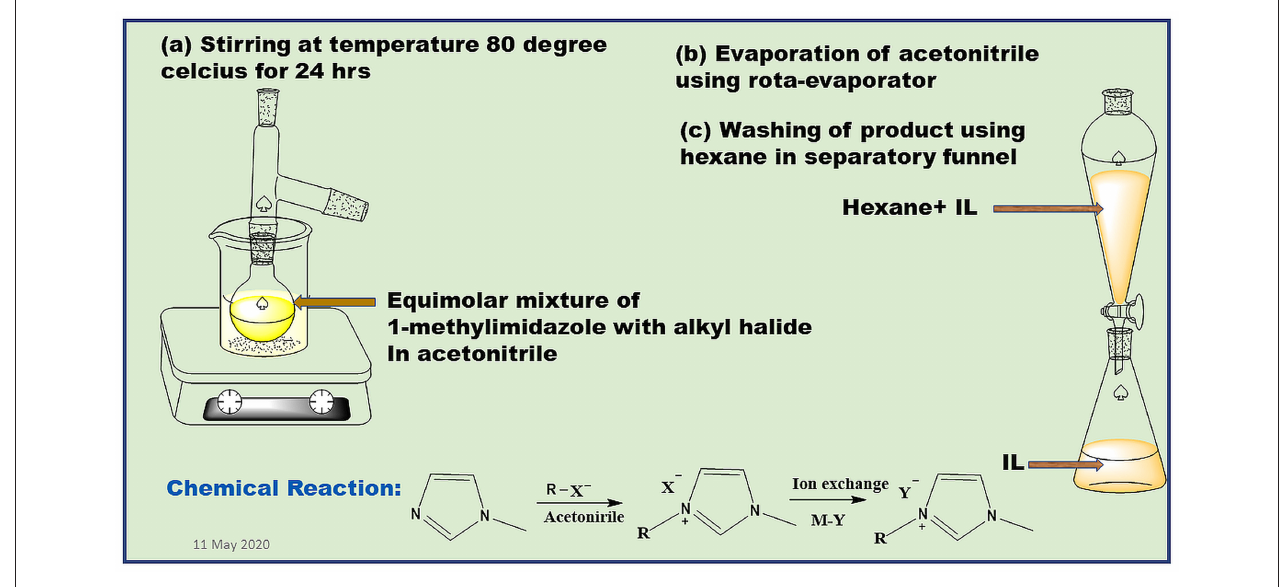
FIGURE 5 | General steps for synthesis of ionic